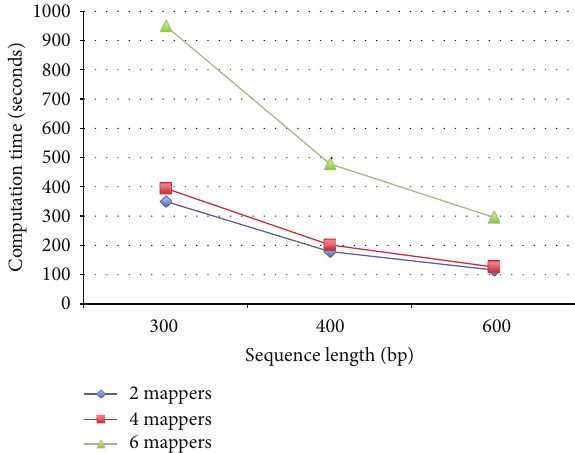
Figure 8: Computation time of cloud-based ORF phylogenetic analysis with different number of mappers and sequence lengths.